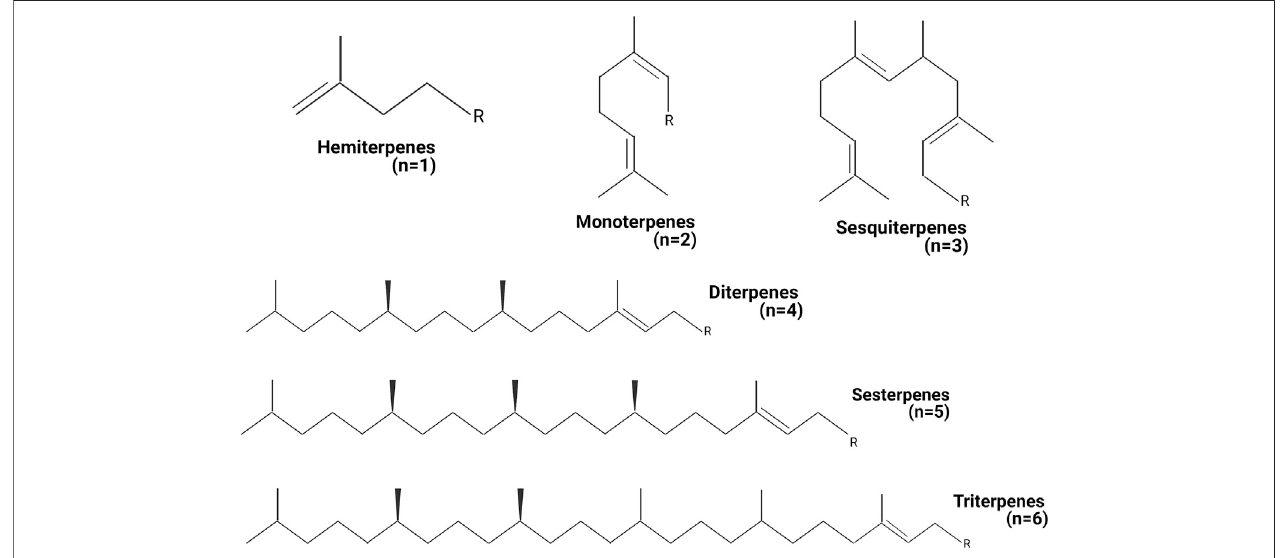
FIGURE 1 | Classi fi cation of terpenes. The terpenes can be classi fi ed by the number of units of isoprene present in the chemical structure. n (cid:1) amount of isoprene units in the different terpene structures. Created with BioRender.com.